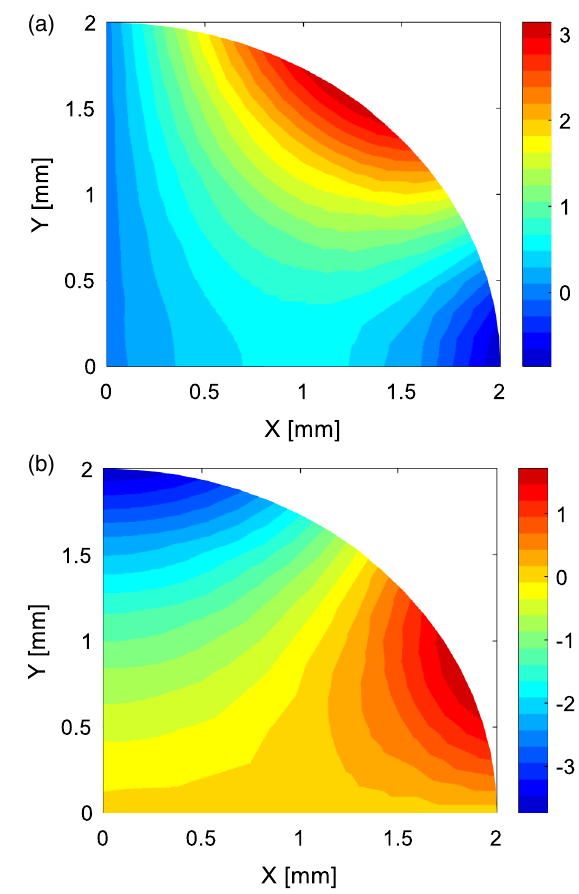
FIG. 18. Phase of quadruple field component and accelerating component.